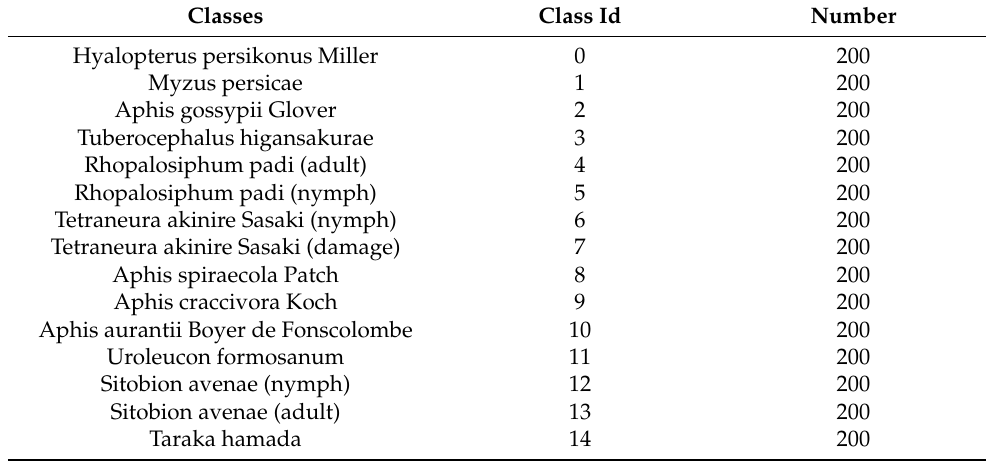
Table 1. The details of the CP15